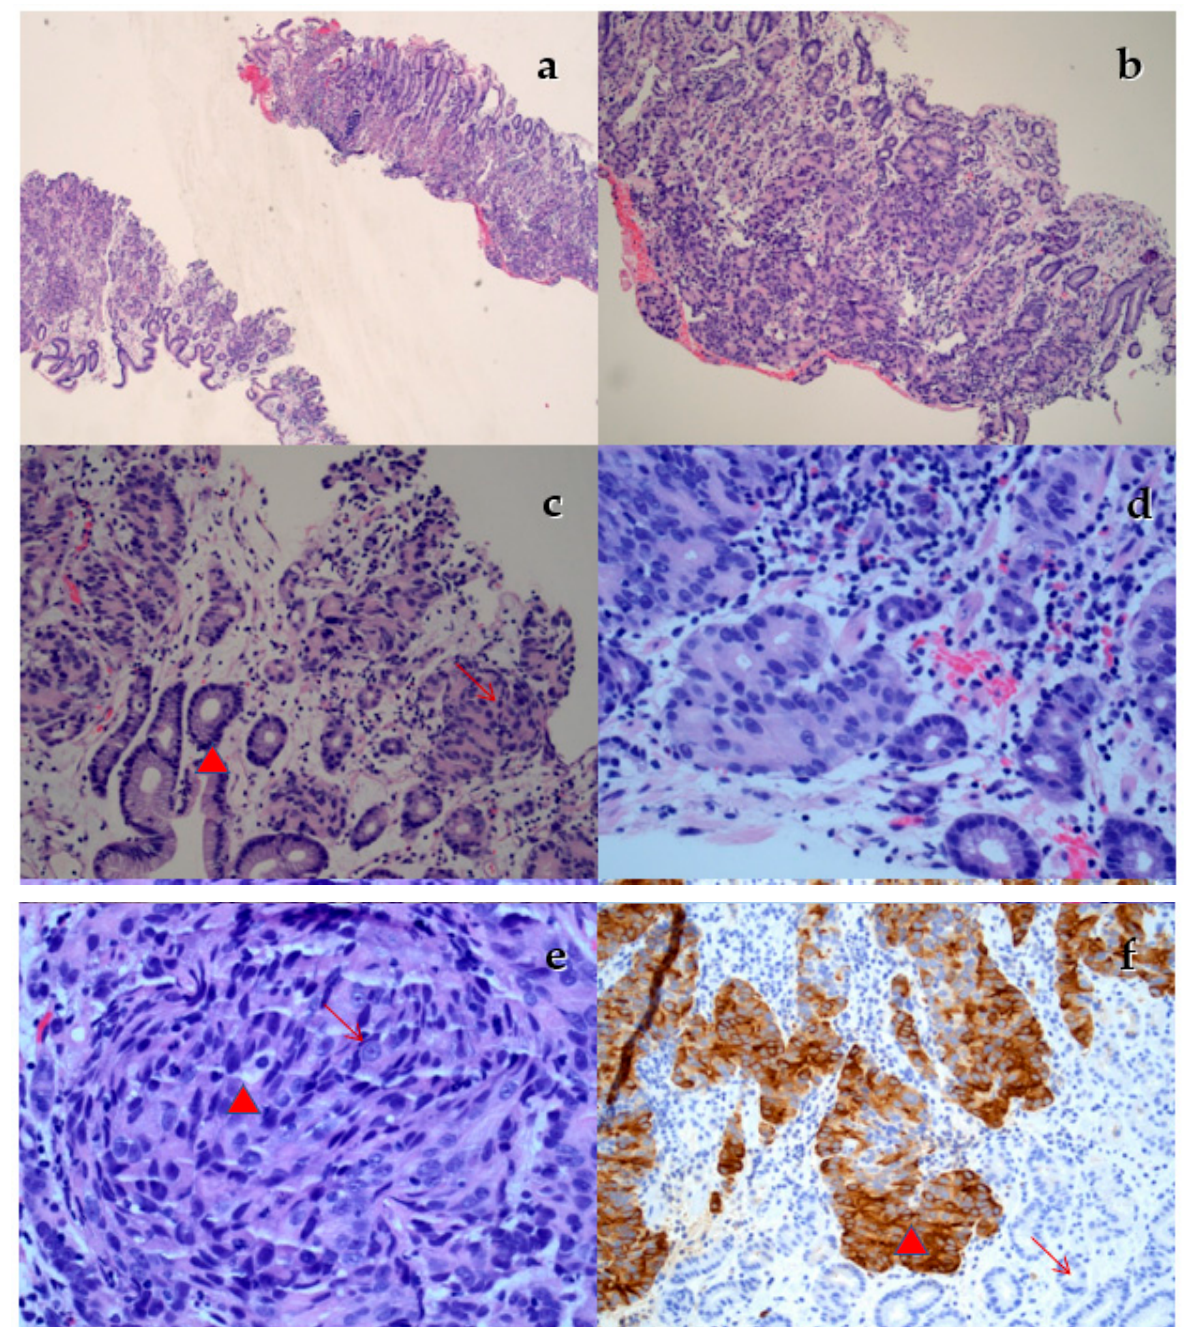
Figure 1. PSA level over time (1 – 10 years).